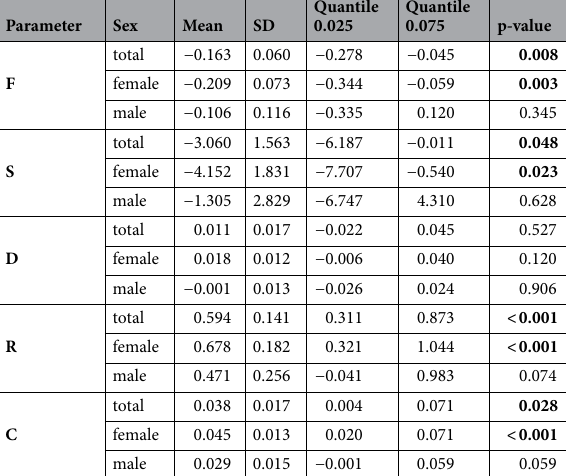
Table 5. Results—changes in muscle properties for all groups from baseline to follow-up (within-participant difference). F = Oscillation Frequency; S = Dynamic Stiffness; D = Logarithmic Decrement; R = Mechanical Stress Relaxation Time; C = Ratio of deformation and Relaxation time; SD = standard deviation; Bold values = p < 0.05; P-value for the simple effects.